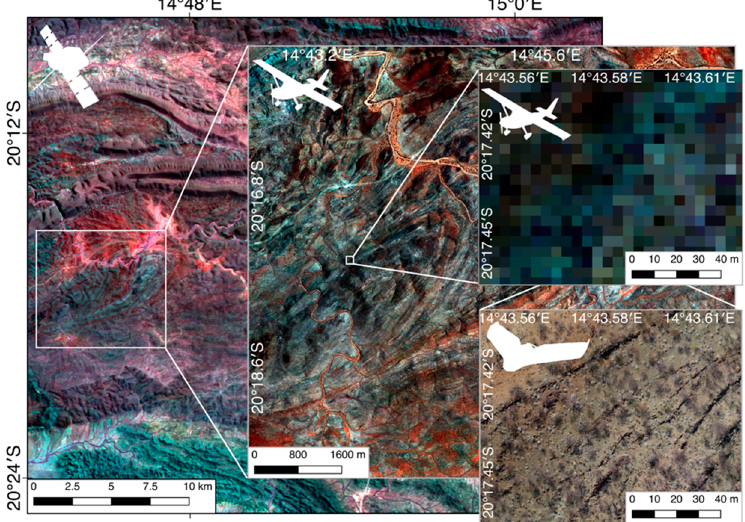
Figure 3. Visual representation of the increase in spatial resolution from satellite sensors, to aircraft- to the high spatial resolution of RPAS-based sensors.